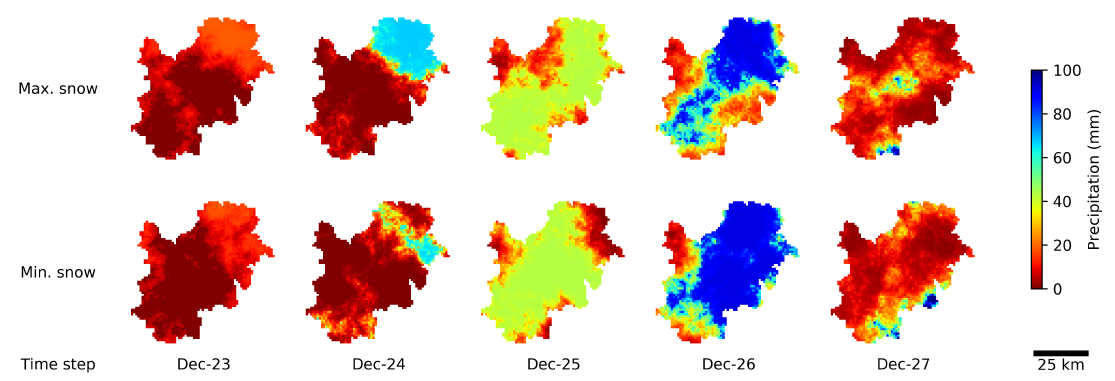
Figure 17. Precipitation on days before the flood for two contrasting